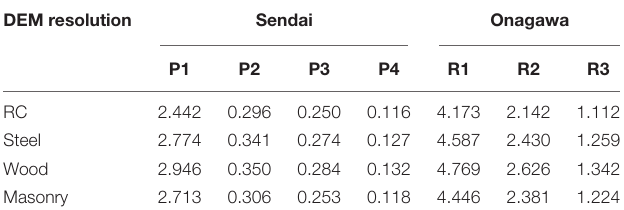
TABLE 2 | Tsunami insurance pure premium rates at different locations (per 1000 insured value).